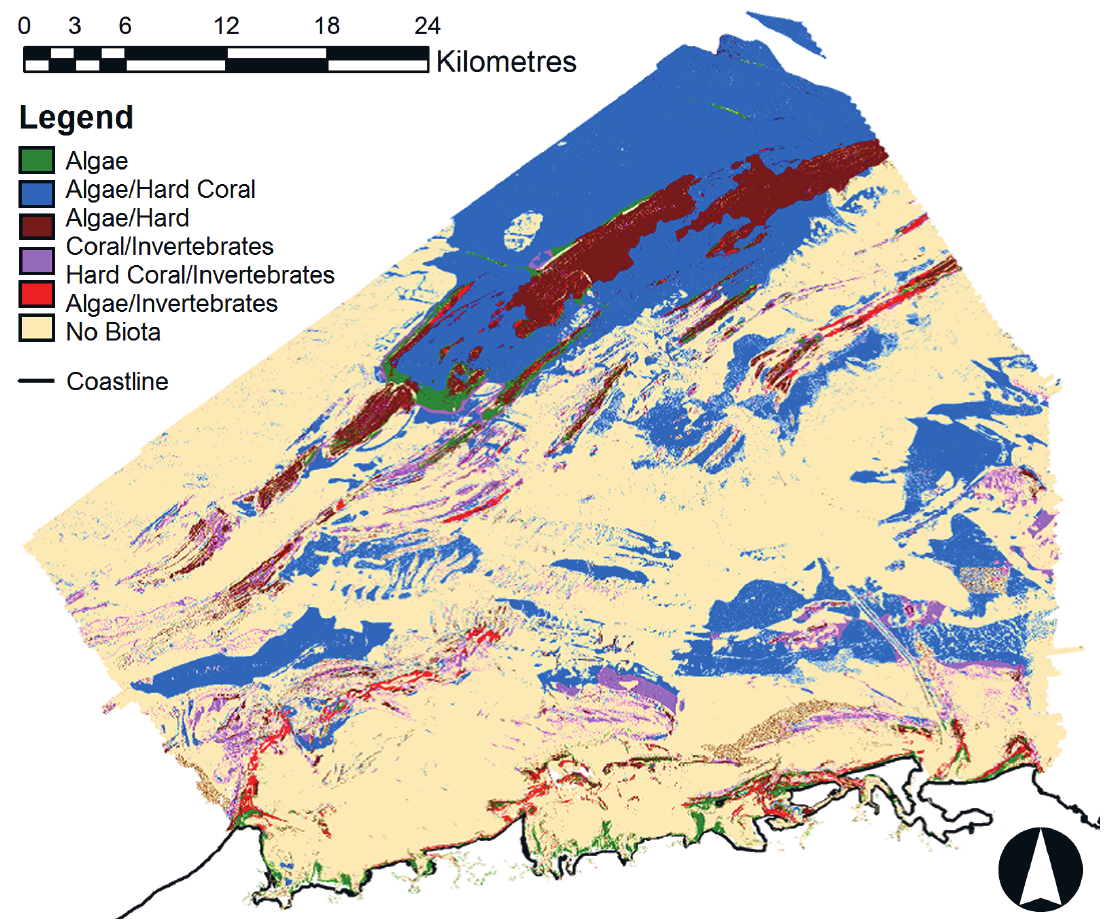
Figure 7. Final habitat classification result showing spatial distribution of